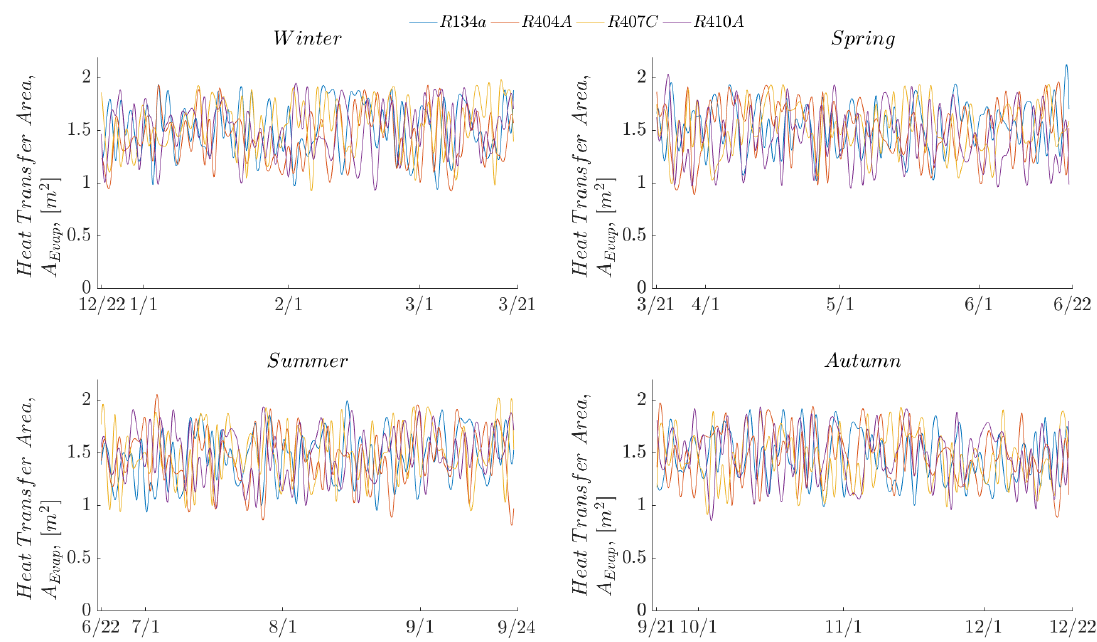
Figure 18. Work time optimization for all refrigerants.